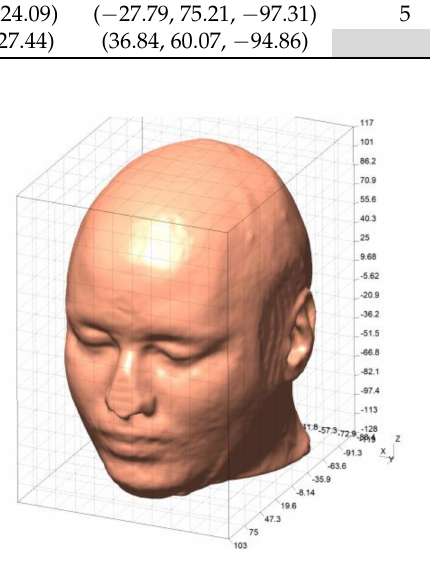
Figure 5. The origin of the coordinate set in the head mesh model; figures were produced by the authors in SimNIBS (1 November